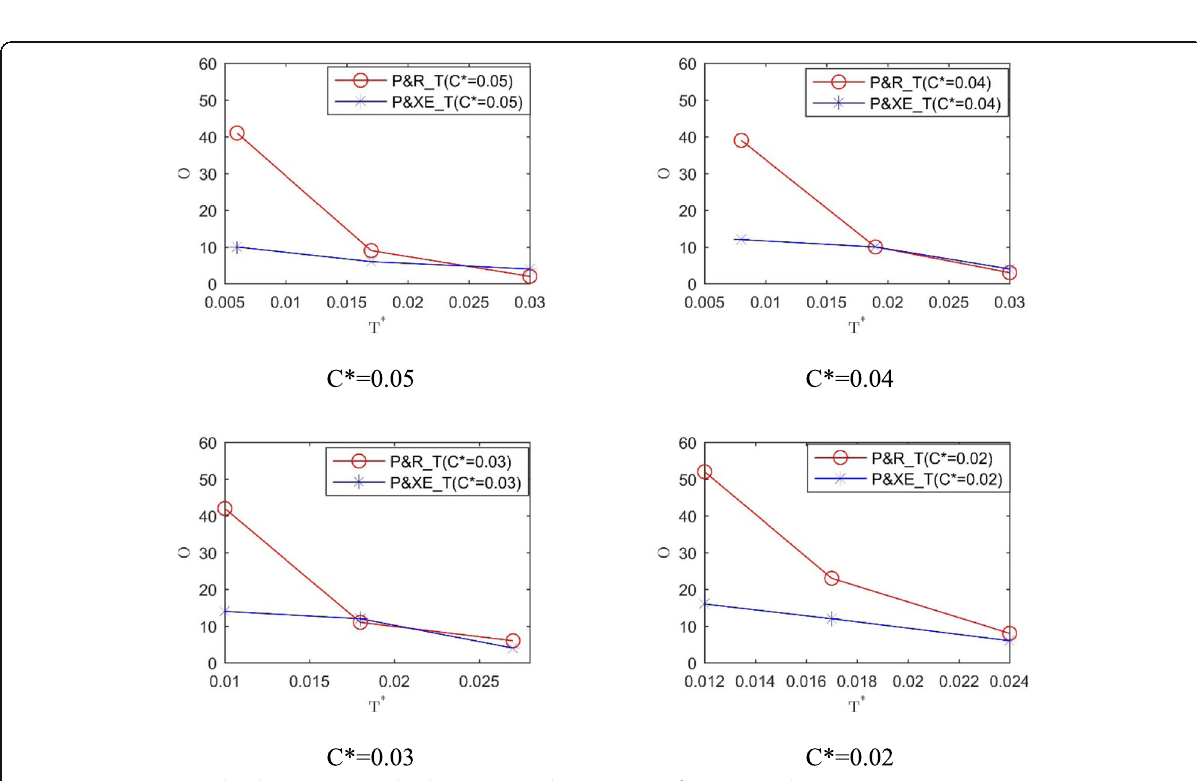
Fig. 13 User storage overhead comparison under the same T * and C * constraints for n = 50 and 10 ≤ m ≤